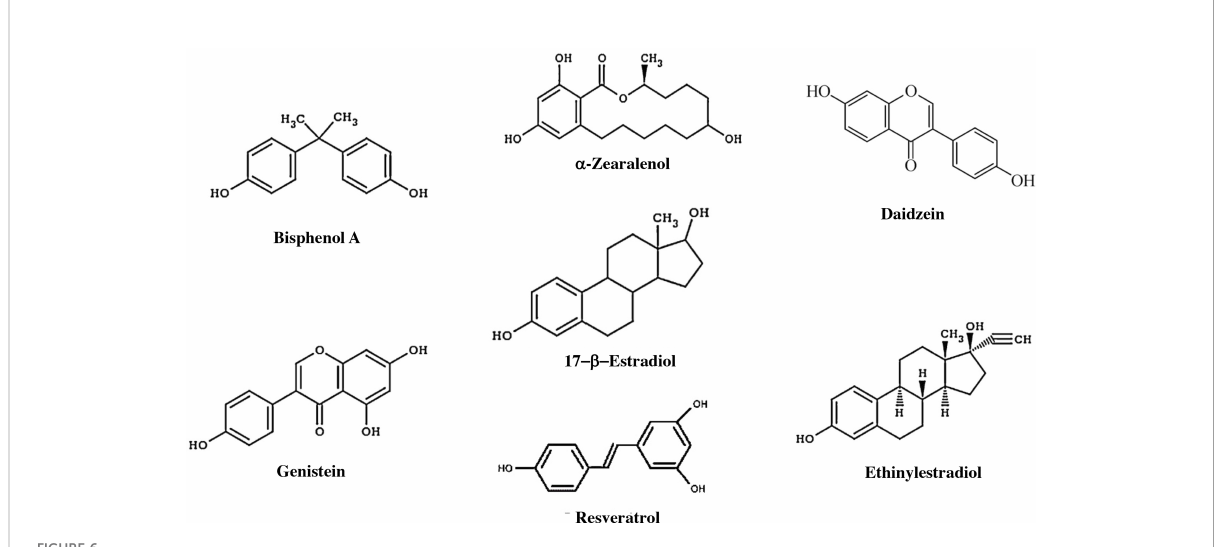
FIGURE 6 Components with estrogenic effects. Estrogens, some endocrine disruptors, and other natural products that have an estrogenic effect. Bisphenol A is an organic compound that is used to manufacture polycarbonate polymers and epoxy resins. a -Zearalanol is a natural compound observed in fungi that is a growth promoter used in veterinary medicine. Daidzein is a natural iso fl avone compound found in products such as soy. Genistein is an iso fl avone found in several plants, including soy. DDT, dichlorodiphenyltrichloroethane. Resveratrol is a compound found in grapes that has an estrogenic effect and may in fl uence aging. Ethinylestradiol is a synthetic compound that is used as a